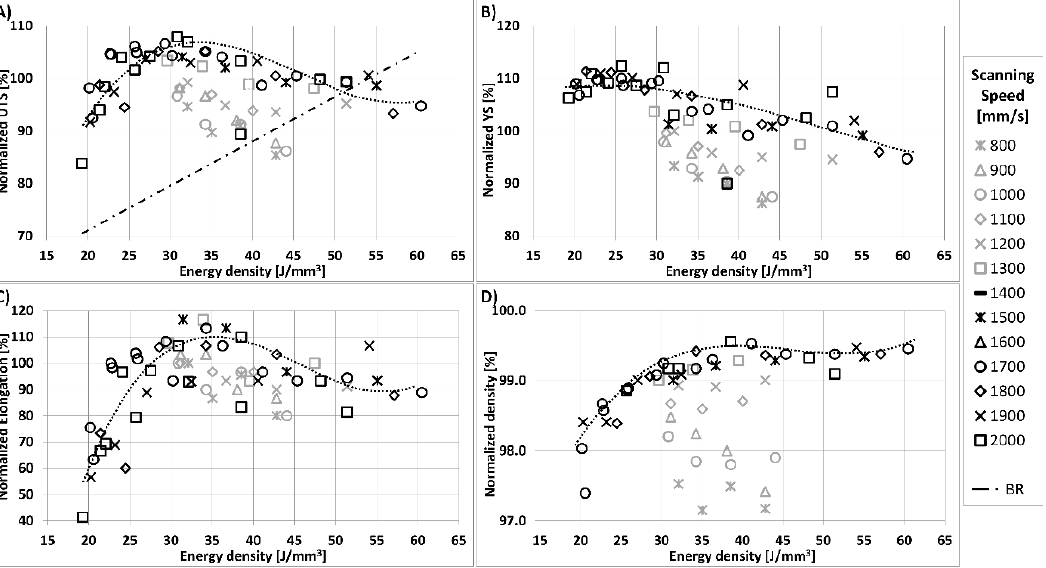
Figure 7. Mechanical properties measured for the setups of step 1 and 2, plotted against the energy density. ( A ) Normalized UTS; ( B ) Normalized YS; ( C ) Normalized elongation; ( D ) Normalized density.